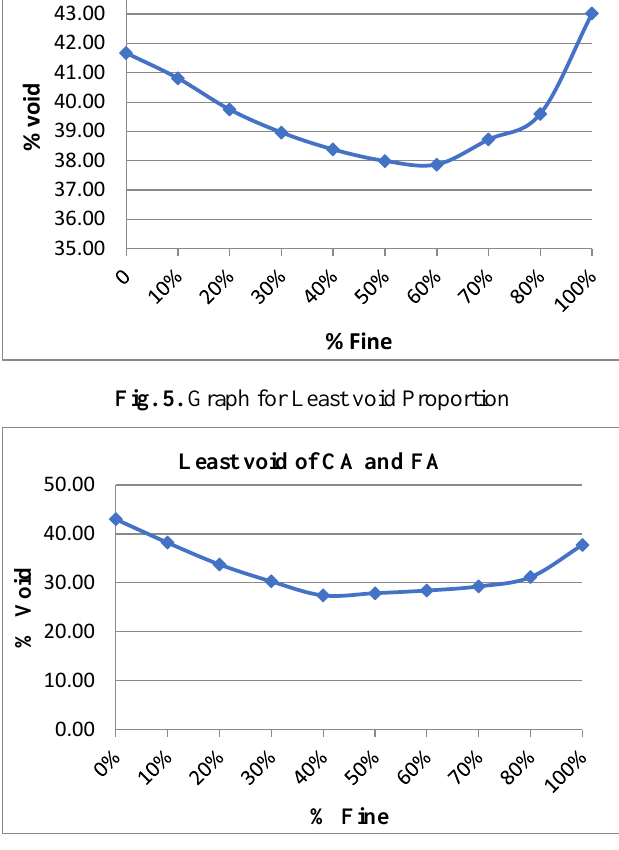
Fig. 6. Graph for Least void Proportion for CA and